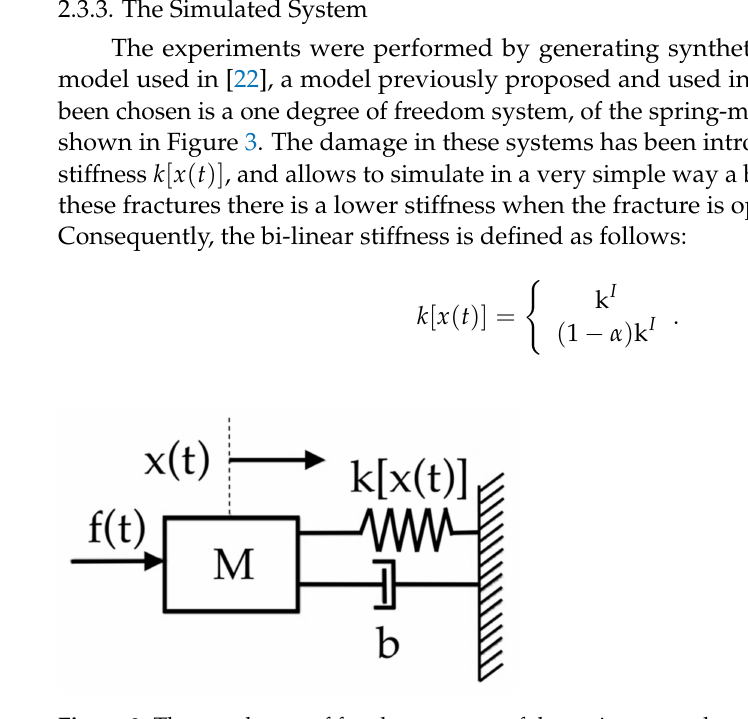
Figure 3. The one degree of freedom system, of the